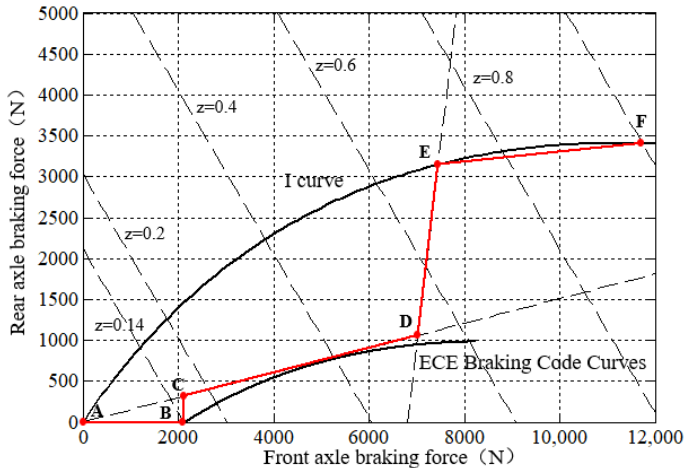
Figure 7. Front and rear axle braking force distribution curve.